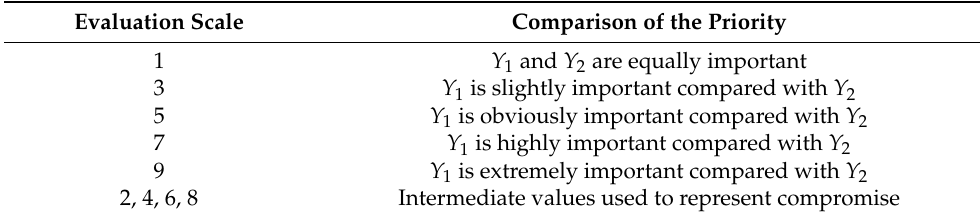
Table 12. Evaluation scale